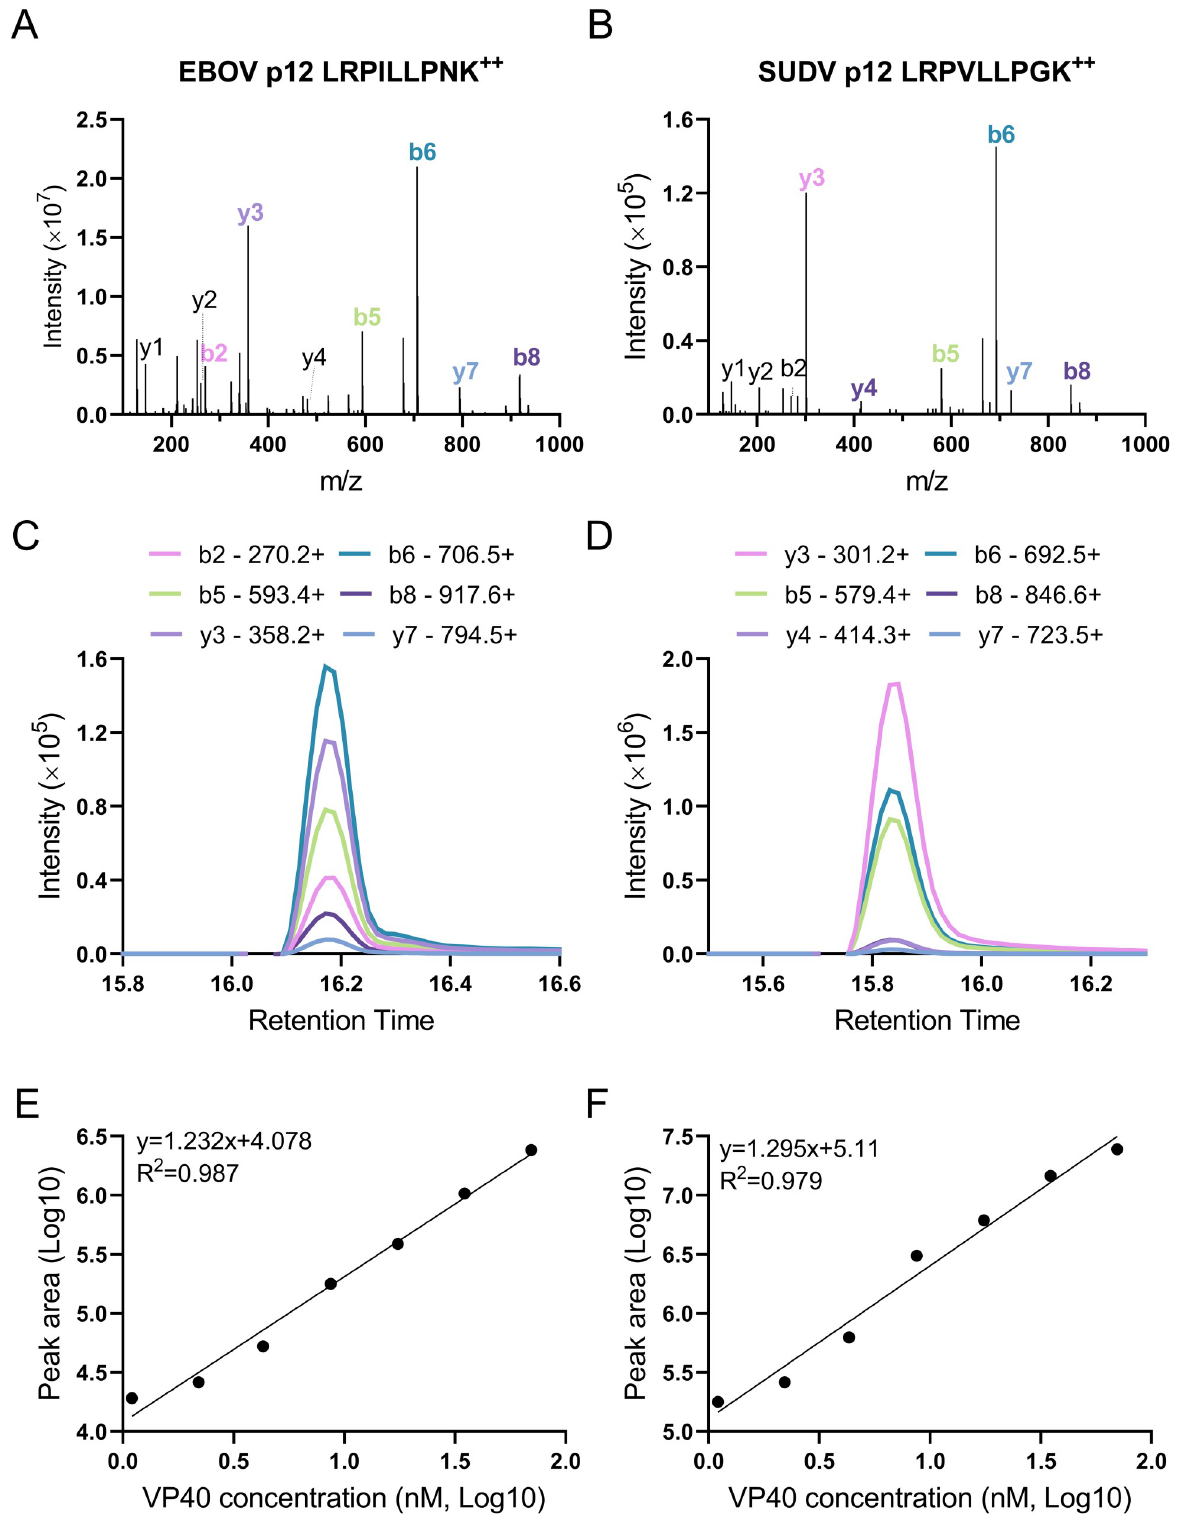
Fig 3. Antibody affinity differences against two VP40 p12 variants measured by MRM. (A-B) The tandem MS spectra of (A) EBOV and (B) SUDV VP40 p12 identified in recombinant protein tryptic digests. All matched ion peaks are annotated, with the six selected p12 MRM